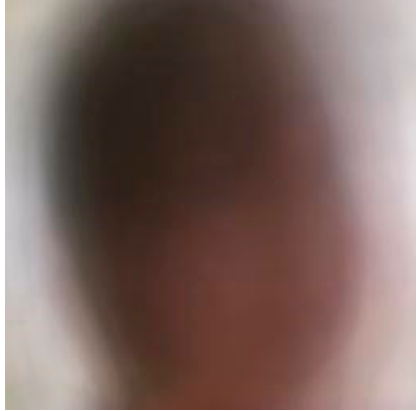
Figure 9. Mean image generated from the dataset.